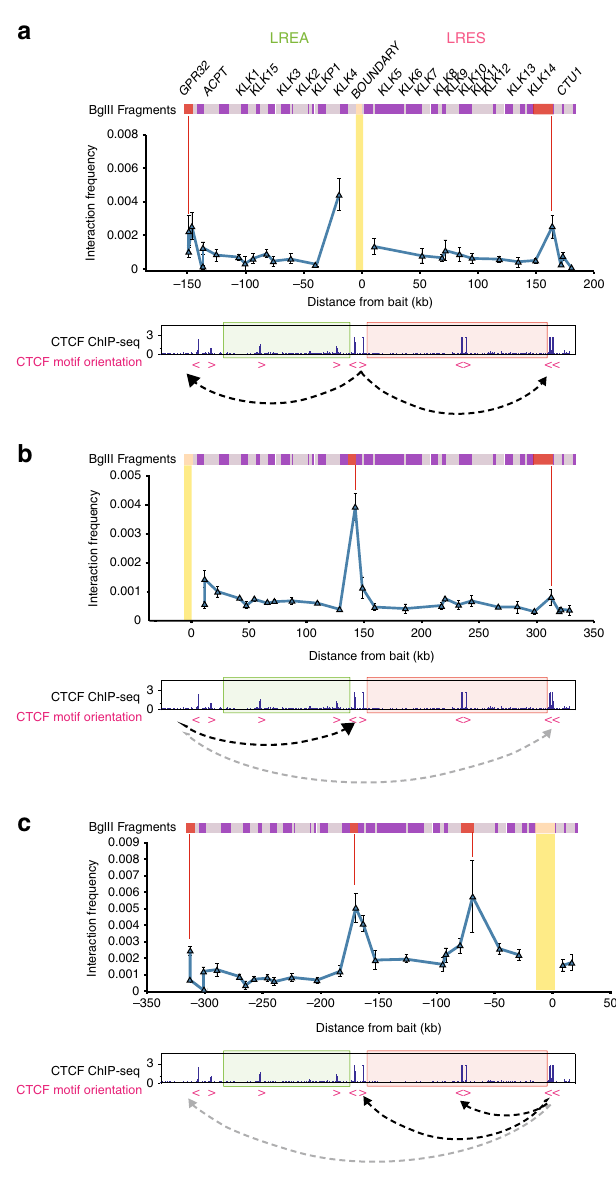
Fig. 2 3D structure of the KLK locus compartmentalises expression domains. a 3C-qPCR at the KLK locus. Bars above the graph illustrate BglII fragments across the region. The 3C bait fragment is indicated by the yellow bar and interacting fragments are shown by red lines (149.2kb upstream from bait, 163.8 kb downstream from bait). The pink arrows indicate the direction of CTCF motifs. The dotted arrows demonstrate the loops indicated by the interaction data. Error bars represent standard error (SE). b As in a , utilising upstream interacting fragment from a as bait. Interacting fragments are 143.2 and 313.0 kb downstream from the bait. c As in a , utilising downstream interacting fragment from a as bait. Interacting fragments are 68.9, 169.8 and 313.0 kb upstream from the